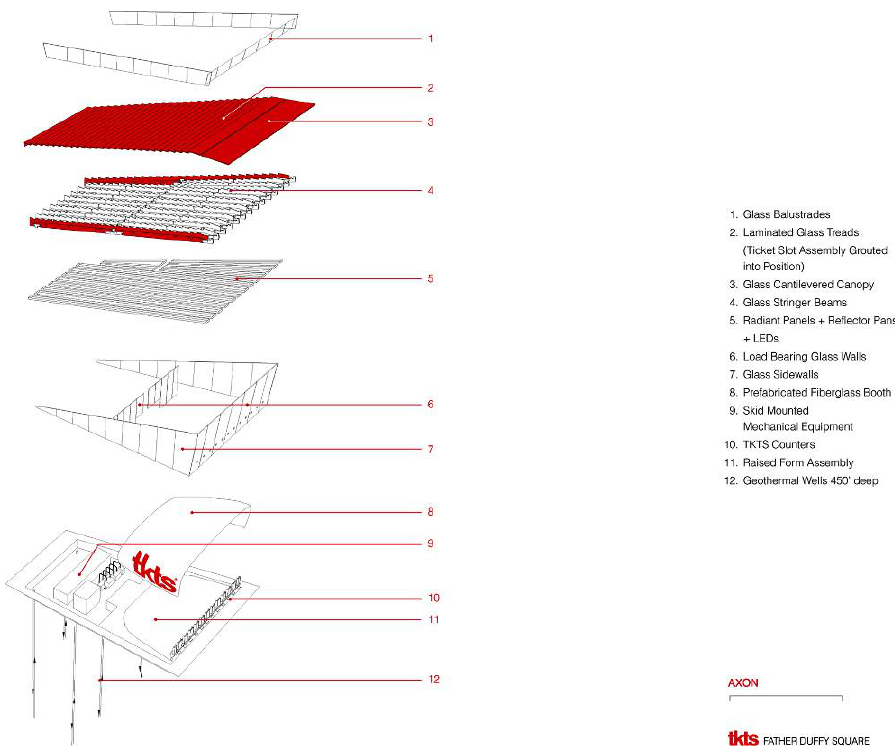
Figure 3: Exploded view of